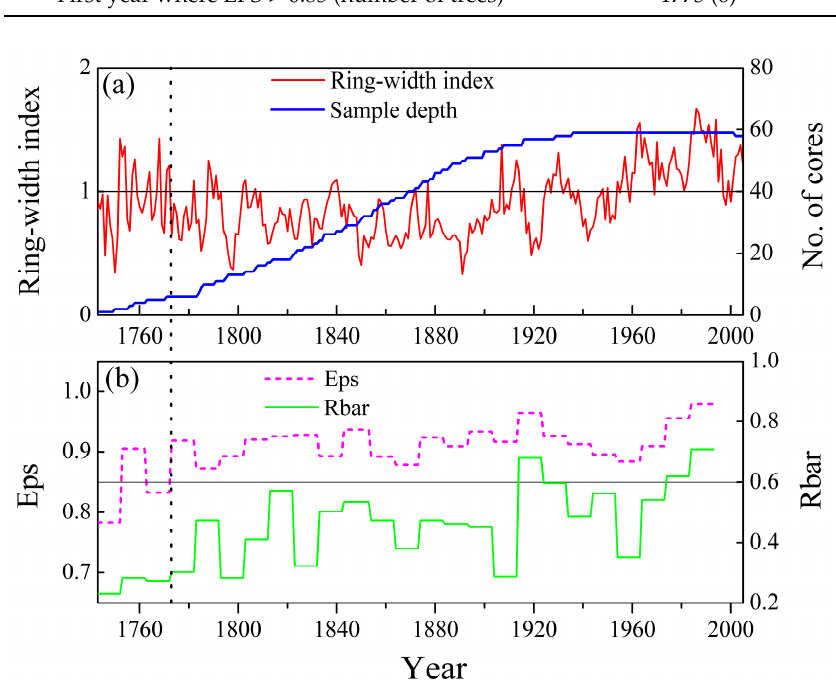
Figure 5. ( a ) Ring-width STD chronology for the period 1743–2005 constructed for Picea jezoensis var. microsperma from Changbai Mountain in the northeast of China. The blue lines indicate the numbers of tree-ring series and ( b ) the expressed population signal (EPS) and average correlation between all series (Rbar) of the STD from AD 1743 to 2005. The vertical dash line indicates the point where EPS was higher than 0.85.